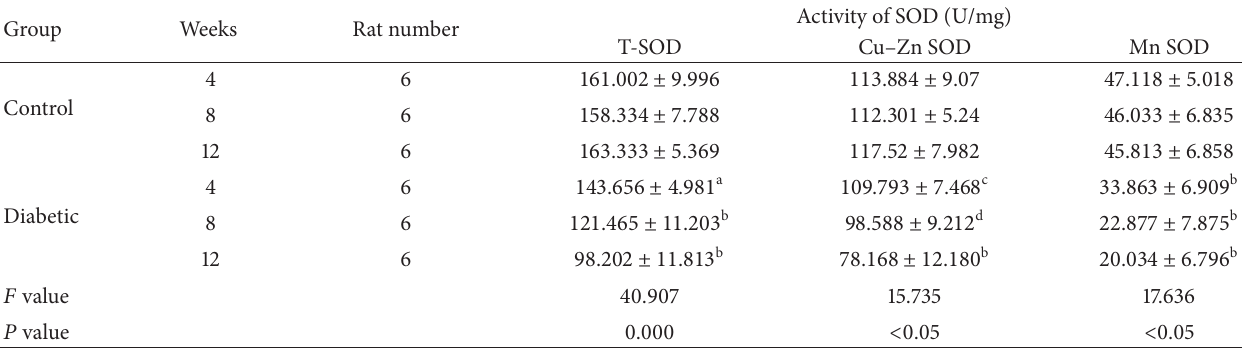
Table 2: Activity comparison of T-SOD, Cu–Zn, and Mn SOD at 4, 8, and 12 weeks.